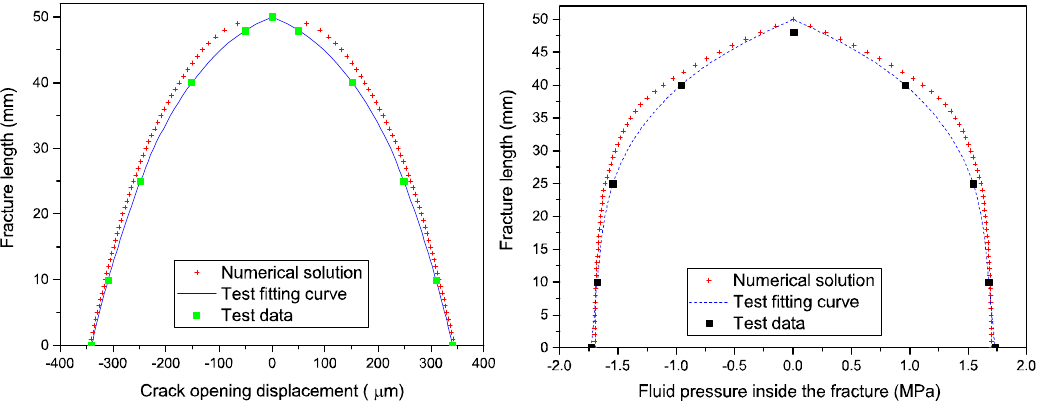
Figure 13. The contours of the stress distributions using FVM-XFEM (unit: MPa).